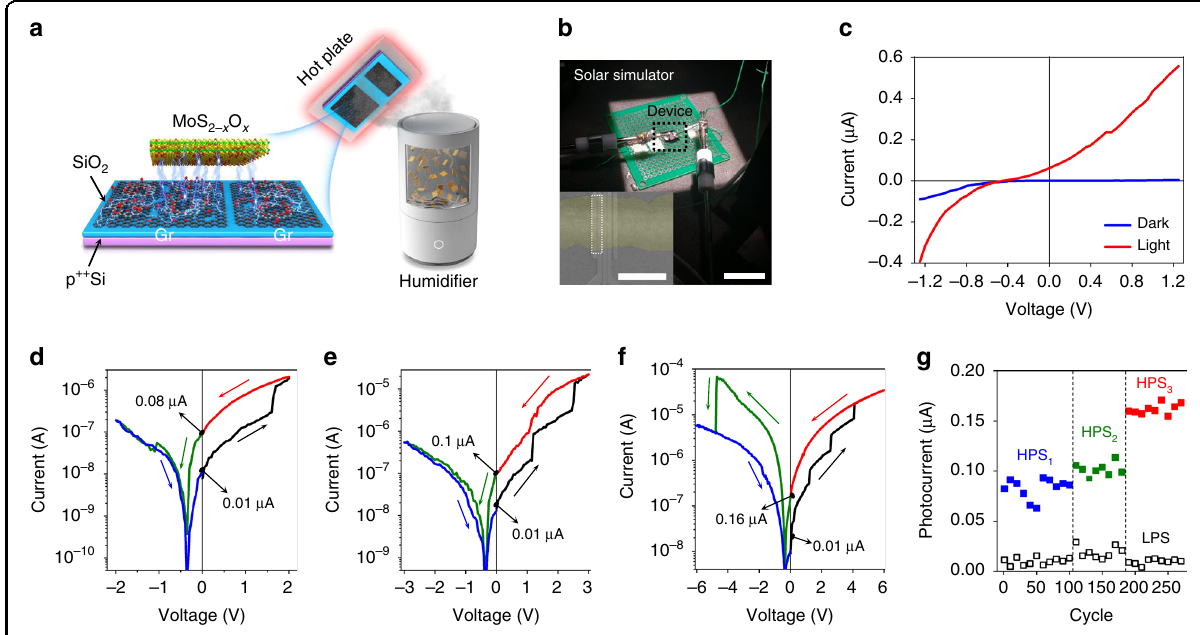
Fig. 1 The basic device with displaced and pinched hysteresis current-voltage characteristics. a Schematic representation of the MoS 2-x O x structure with CVD-grown graphene electrodes of different contact areas and the experimental process of LPE fi lm deposition using the ultrasonic deposition setup. Spheres: carbon — black, oxygen — red, molybdenum — green, sulfur — yellow. b Optical image of the G/M/G device with solar light illumination. Scale bar, 2 cm. The inset shows an SEM image of another device, scale bar, 250 μ m. the white rectangle indicates the area (256.2 × 62.5 μ m 2 ) of a G/M/G device. c Current-voltage characteristics of G/M/G devices at HPS in the dark (blue line) and in the light (red line). d – f Multilevel photoresponse switching characteristics at a discrete input bias voltage. g Endurance of photoresponse states (HPS 1 , HPS 2 , HPS 3 , LPS) over hundreds of switching cycles (reading at 0 V